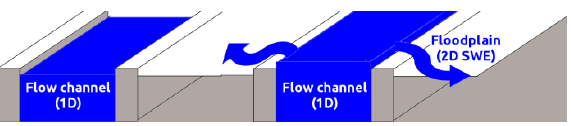
Figure 4. Possible integration between the 1D and the 2D models. The 1D approach can be used within the flow channel, while the 2D numerical solution can be used to analyse inundation alongside the river levees on the